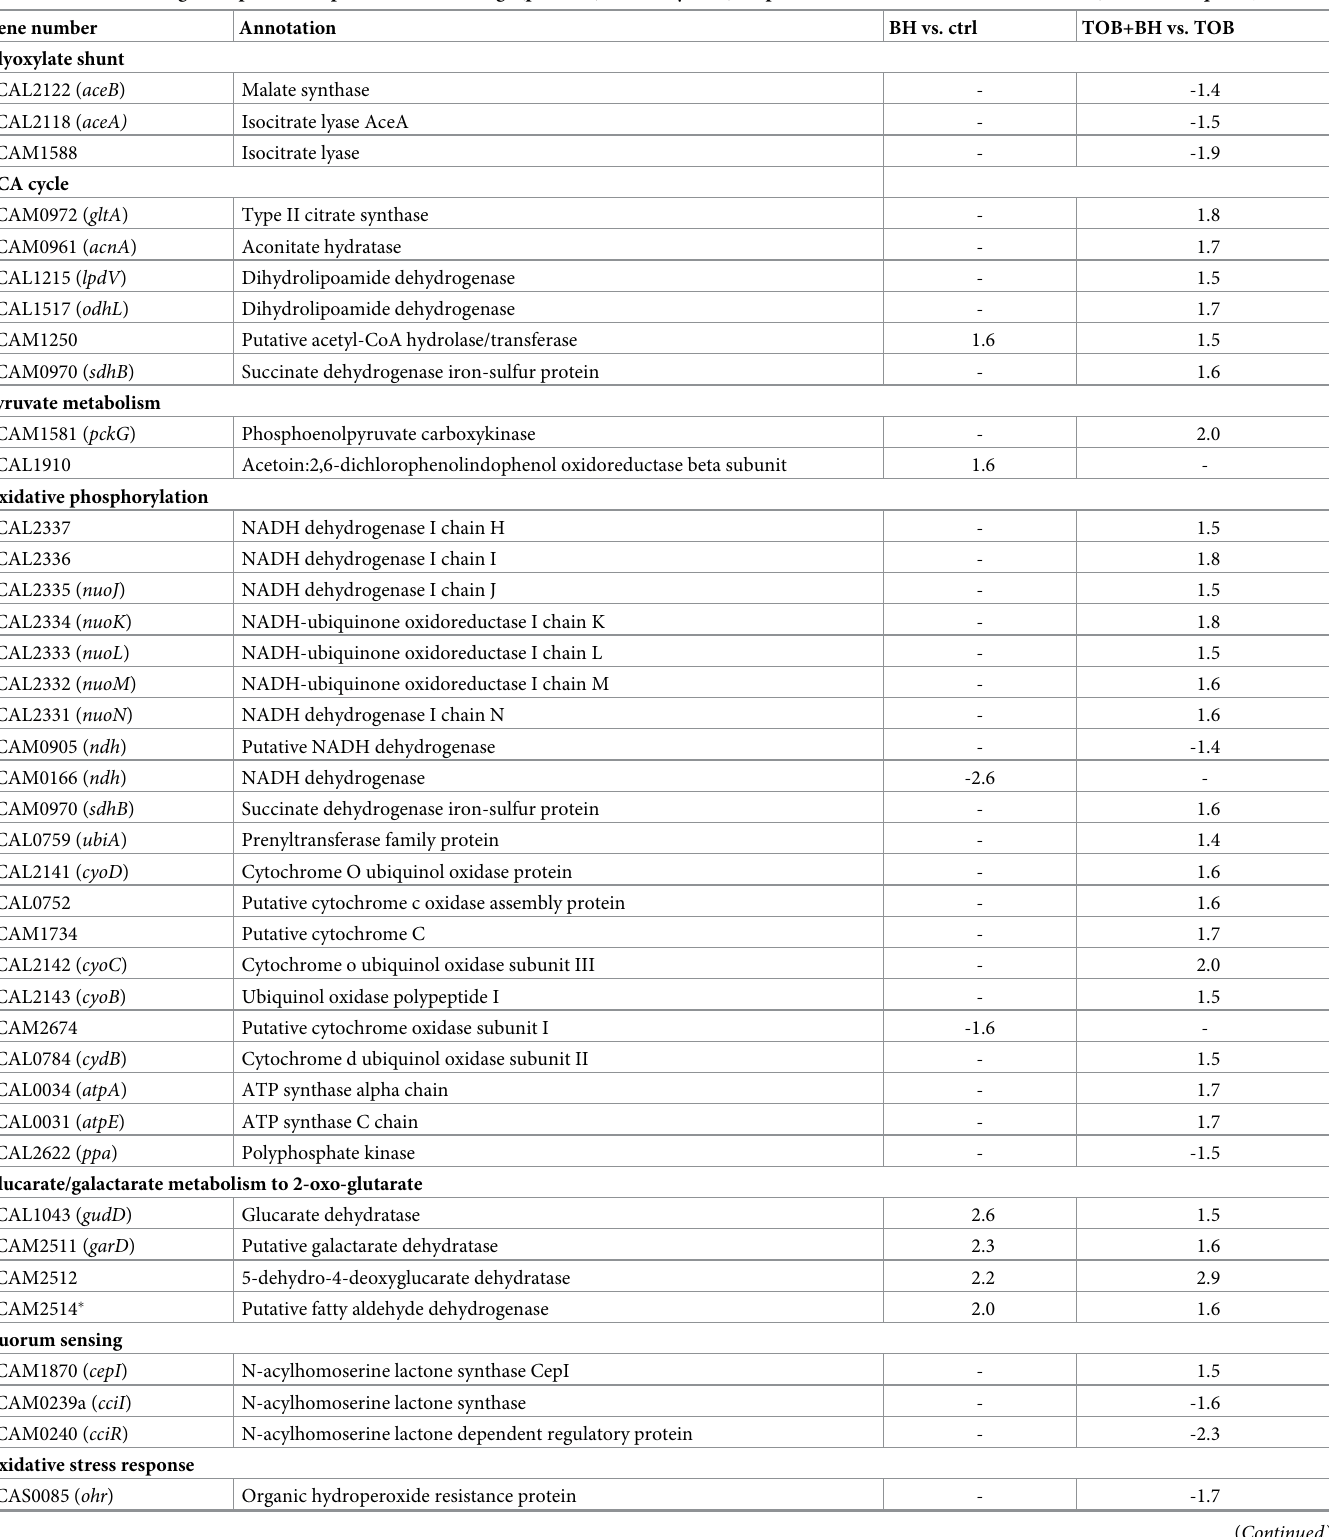
Table 3. Differences in gene expression expressed as fold change (p < 0.05) caused by BH (compared to TOB or to an untreated control) in B . cenocepacia J2315. Gene